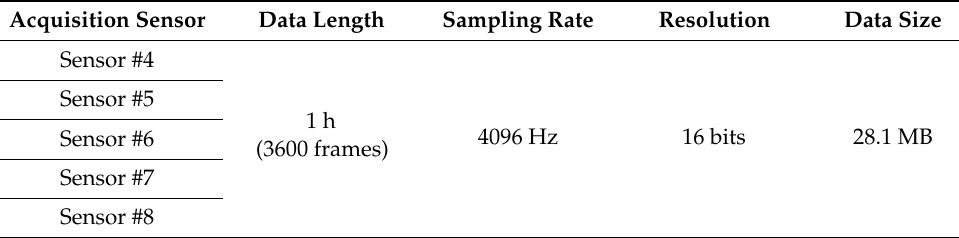
Table 1. Detailed information of acoustic sensor signals for performance evaluation.